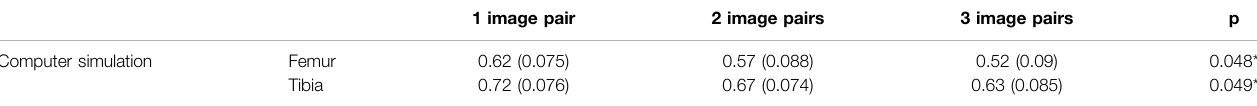
TABLE 1 | The means (standard deviations) of the RMSE (unit: mm) for the femur and tibia shape reconstruction using 1, 2, and 3 image pairs by computer simulation. p values of a univariate analysis with a polynomial linear test are also given for the trend of reconstruction accuracy with increasing image pairs.